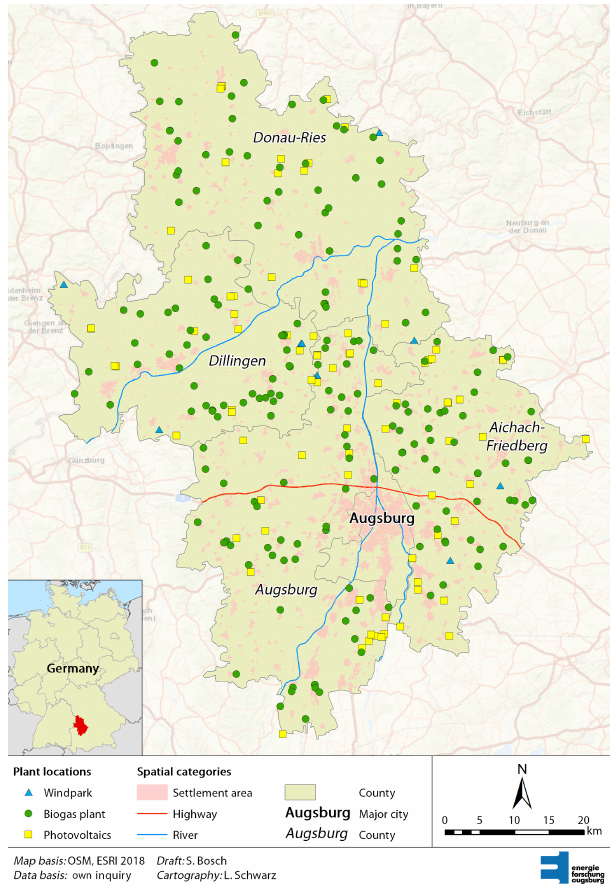
Figure 1. Spatial Distribution of RET in the Research